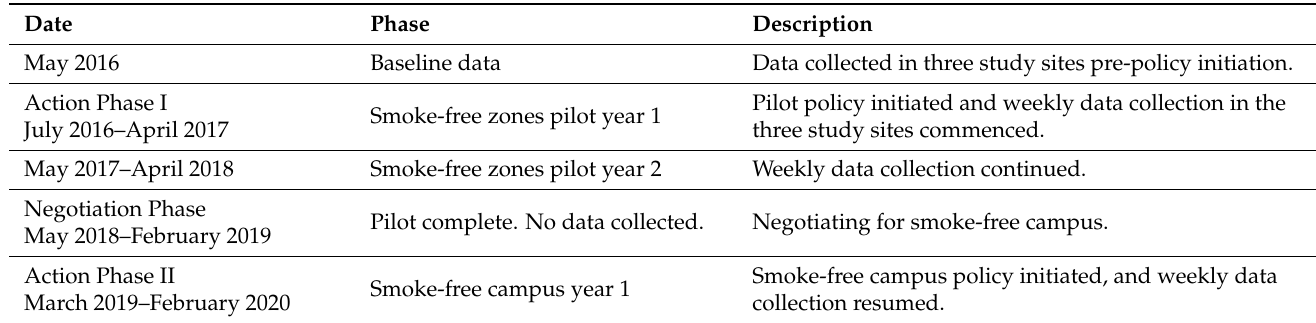
Table 1. Phases of data collection from May 2016–February